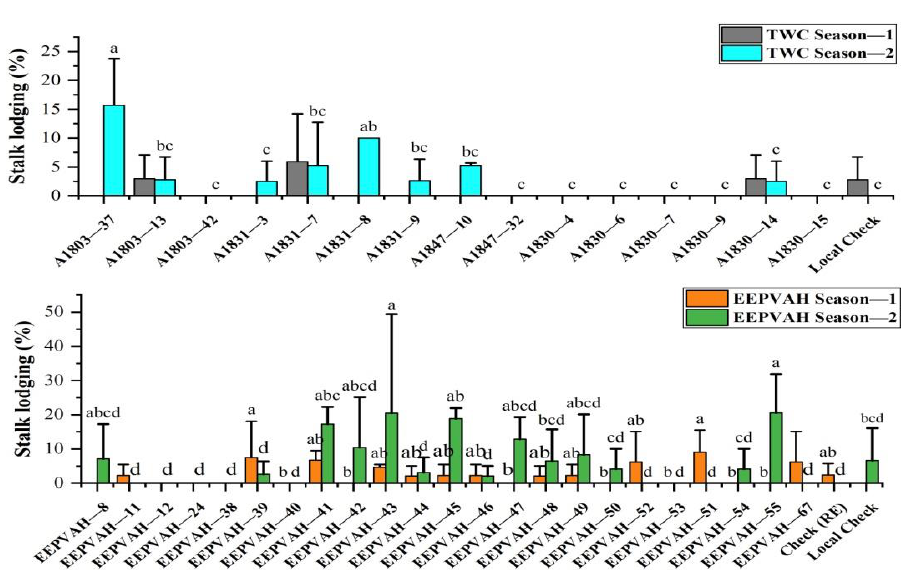
significant effect, similar statistical letters within a parameter (column) indicates non-significant difference among the genotypes.